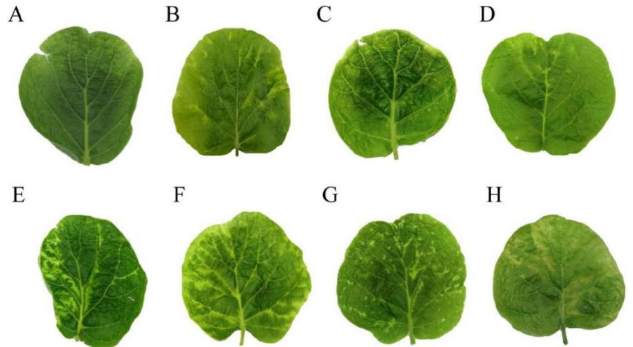
Figure 6. Comparison of symptoms of the 5′ -terminal non-coding region insertion type and the non- insertion type of AcCRaV. Note: ( A – D ), 5′ -terminal non-coding region insertion of AcCRaV; ( A ), PJ10; ( B ), PJ13; ( C ), PJ43; ( D ), CX5; ( E , F ), non-insertion AcCRaV; ( E ), PJ39; ( F ), QL3; ( G ), QL7; ( H ),